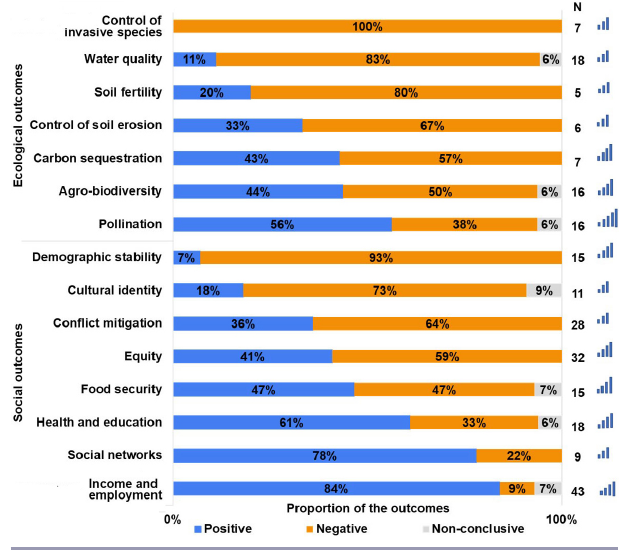
system were not clear with the possibility of having almost equal positive and negative outcomes (odds ratio = 0.90, p-value = 0.66). Fig. 3 . Ecological and social outcomes of urbanization on regional farming systems (N = number of cases per outcome variable). Bars on the right indicate the average strength of evidence; each bar represent one point of strength (interpreted in Table